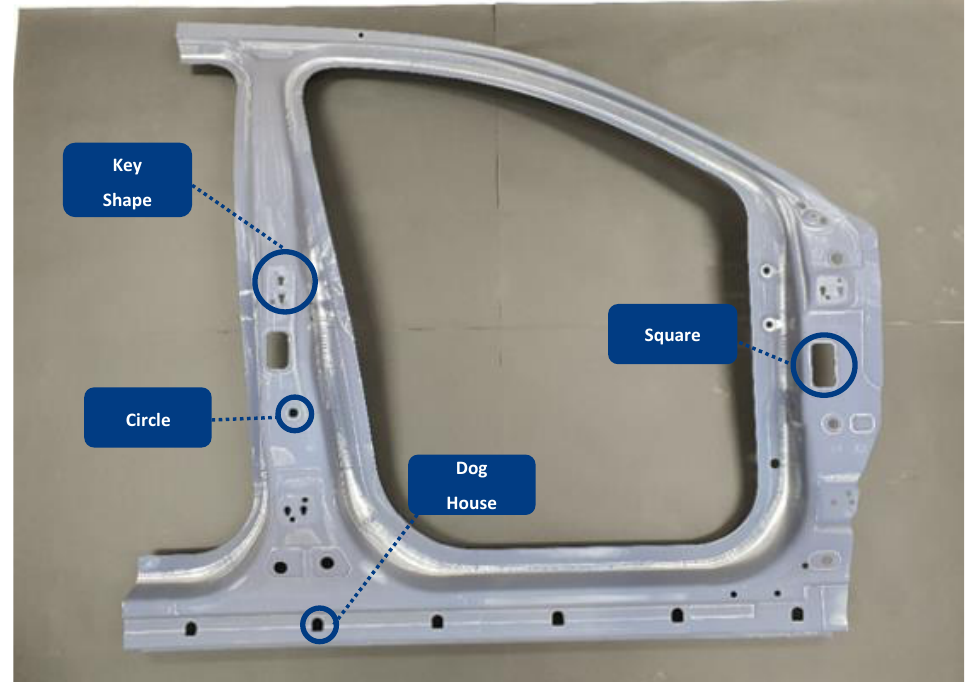
Figure 3. Example of Plain Data.